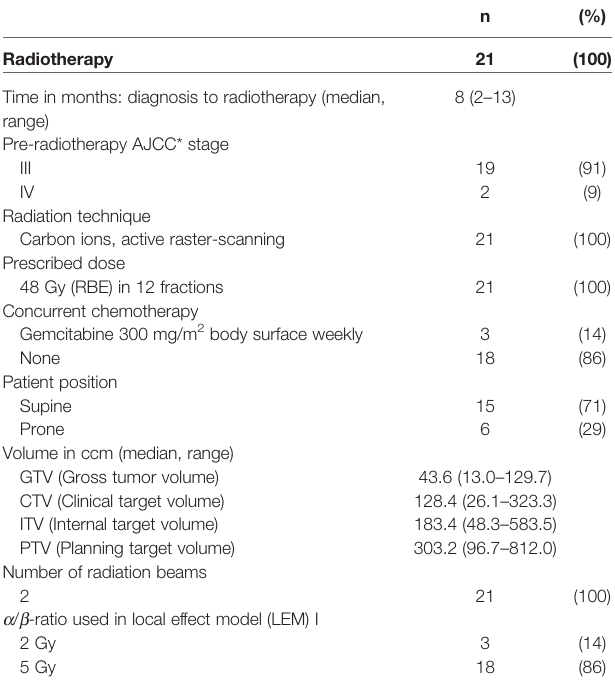
TABLE 2 | Treatment